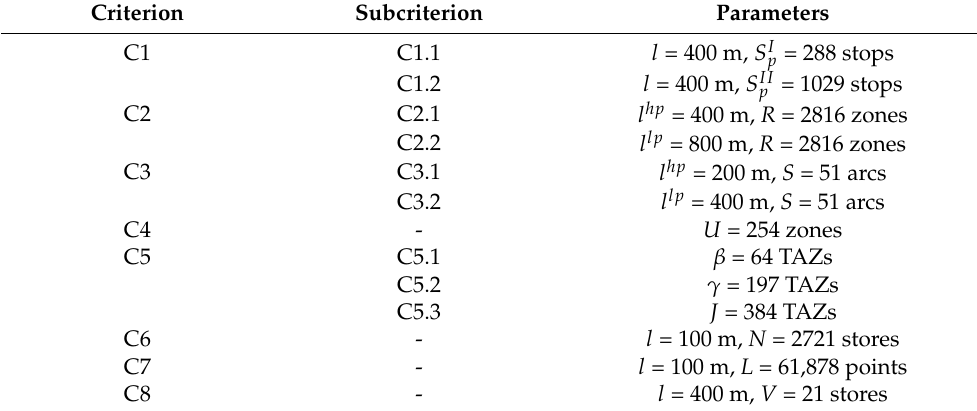
Table 4. Parameters for a considered family of criteria—applied for Poznan. Criterion